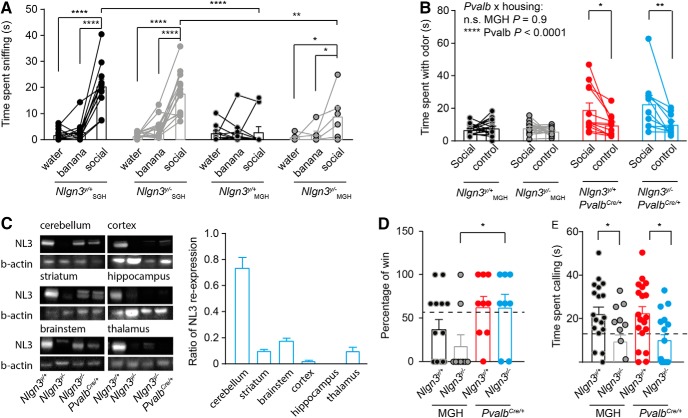
Adult (2- to 4-mo-old) Nlgn3y/– mice modify the social behavior of their littermates. A, Nlgn3y/+ and Nlgn3y/– mice from SGH and Nlgn3y/– mice from MGH showed increased interest in social odors compared with water, whereas this increased interest was absent in Nlgn3y/+ mice from MGH. Note that Nlgn3y/+ and Nlgn3y/– mice from SGH spent more time sniffing the social odor compared with Nlgn3y/+ and Nlgn3y/– mice from MGH, respectively. B, Nlgn3y/+PvalbCre/+ and Nlgn3y/–PvalbCre/+ mice showed an increased interest for social odors compared with Nlgn3y/+ and Nlgn3y/– mice from MGH. C, Western blot analysis shows a ratio of re-expression of 0.7 in the cerebellum, 0.15 in the brainstem, 0.1 in the striatum, 0.1 in the thalamus, and 0.04 in the cortex and no re-expression in the hippocampus. Note that the upper band in the brainstem Nlgn3y/– sample is most likely unspecific, as it appears in protein samples from Nlgn3y/– mice. D, Nlgn3y/– and Nlgn3y/+ mice from MGH lost more frequently against an unfamiliar submissive mouse compared with Nlgn3y/–PvalbCre/+ and Nlgn3y/+PvalbCre/+ mice. No difference in the percentage of wins against an unfamiliar submissive male was found in the tube test between Nlgn3y/+PvalbCre/+ and Nlgn3y/–PvalbCre/+ mice. Note that Nlgn3y/+ and Nlgn3y/– mice from MGH data are replotted from Fig. 3A. The dotted line represents the mean percentage of wins for Nlgn3y/+ mice from SGH. E, Nlgn3y/– mice from MGH and Nlgn3y/–PvalbCre/+ mice spent less time calling a female in estrus than Nlgn3y/+ mice from MGH and Nlgn3y/+PvalbCre/+mice, respectively. The dotted line represents the mean time sent calling for Nlgn3y/+ mice from SGH, replotted from Fig. 3B. Values are represented as mean ± SEM. Statistical significance was tested by two-way ANOVA repeated-measures (A), two-way ANOVA (B, D, and E), and post hoc Sidak’s multiple comparison test. *P < 0.05; **P < 0.001; ****P < 0.0001.